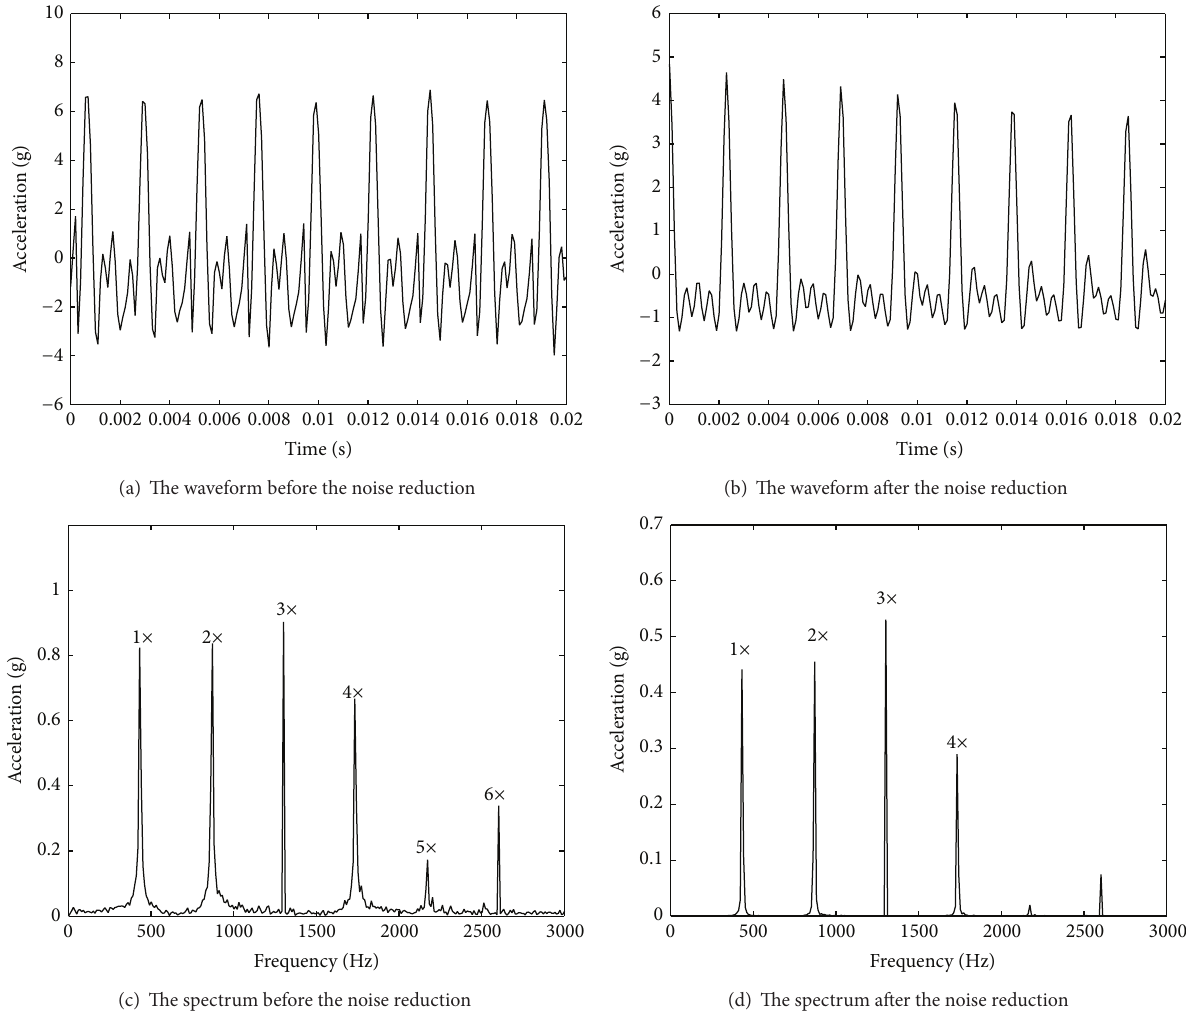
Figure 10: The time domain waveform and frequency spectrum before and after the noise reduction when the rotating speed is 26000 rpm.